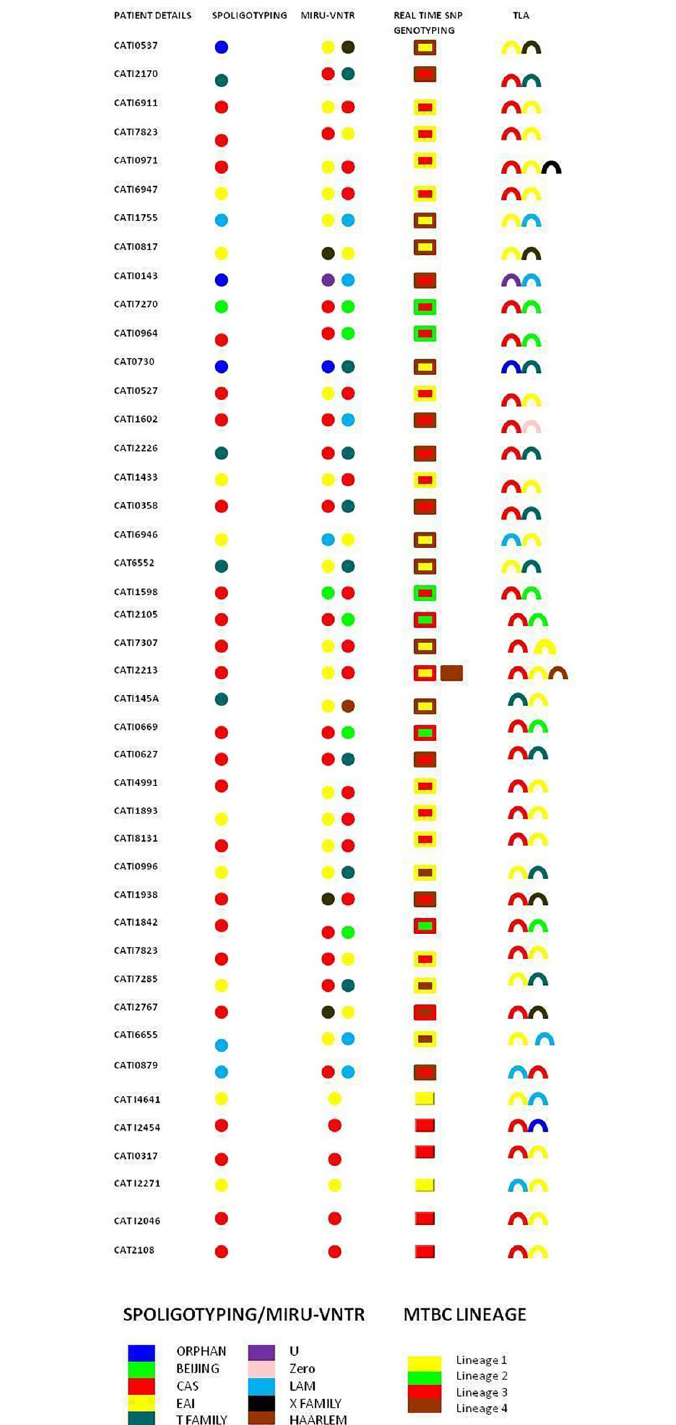
Fig 1. Baseline culture spoligotyping along with results of MIRU-VNTR, SNP typing and single colony spoligotyping (from TLA) used for detection of polyclonal infections. [17, 54–55] Twenty-nine samples gave concordant results by different genotyping techniques and Single Colony Spoligotyping (from TLA). Three samples revealed Orphan in baseline Spoligotyping but MIRU-VNTR and SNP genotyping identified mixed infection. Five cultures revealed discordant genotyping data on comparing three typing techniques and Single Colony Spoligotyping